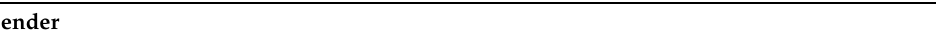
Table 1. The operations in the sender and